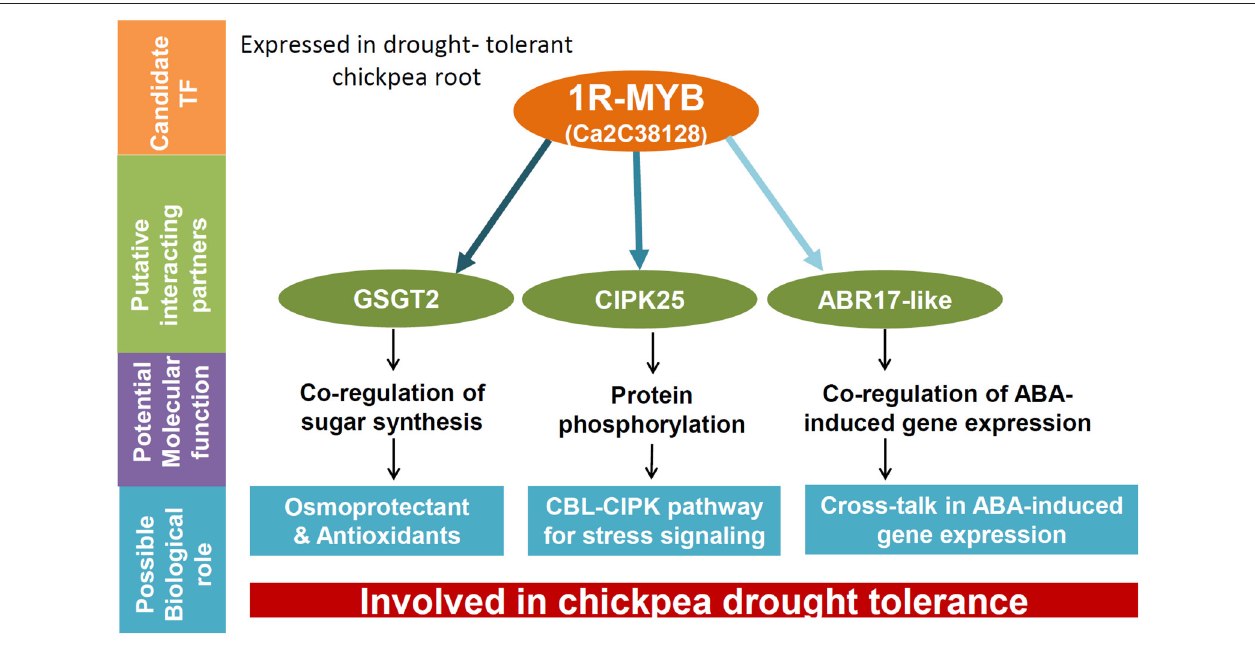
FIGURE 5 | A hypothetical model proposing a possible role for the 1R-MYB TF in co-regulating drought tolerance in chickpea. The Y2H analysis involving the candidate TF, 1R-MYB suggests GSGT2, CIPK25, and ABR17-like proteins as possible co-regulators for drought tolerance in chickpea root. These proteins have been known to be involved in various signal transduction and stress responses to drought from previous reports and has been depicted in the figure. The color intensity of the arrows indicate the strength of interactions observed through biochemical and qRT-PCR analyses in the present study.